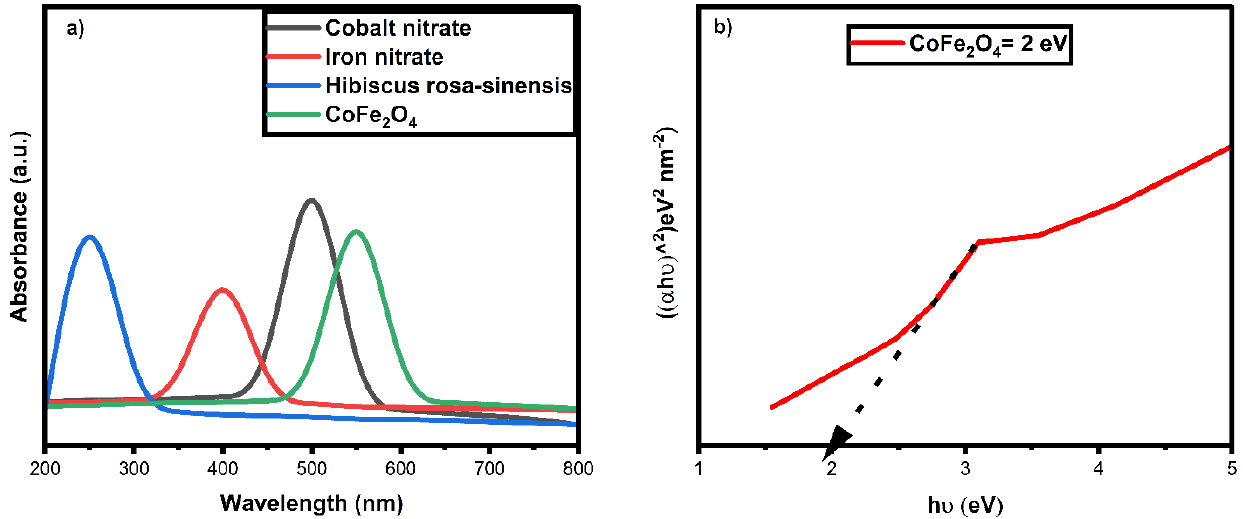
Figure 3. UV-Visible cobalt nitrate, iron nitrate, plant extract, and absorbance ( a ) and bandgap spec- trum ( b ) of the biosynthesized CoFe 2 O 4 nanoparticles. spectrum ( b ) of the biosynthesized CoFe 2 O 4